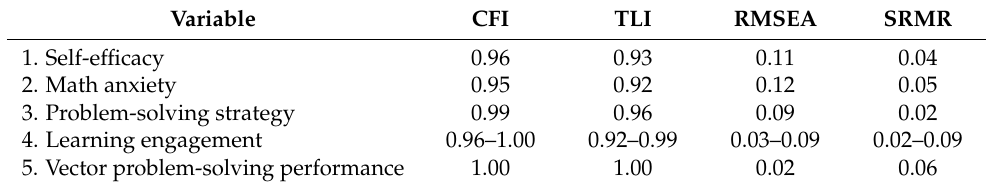
Table 3. Results of confirmatory factor